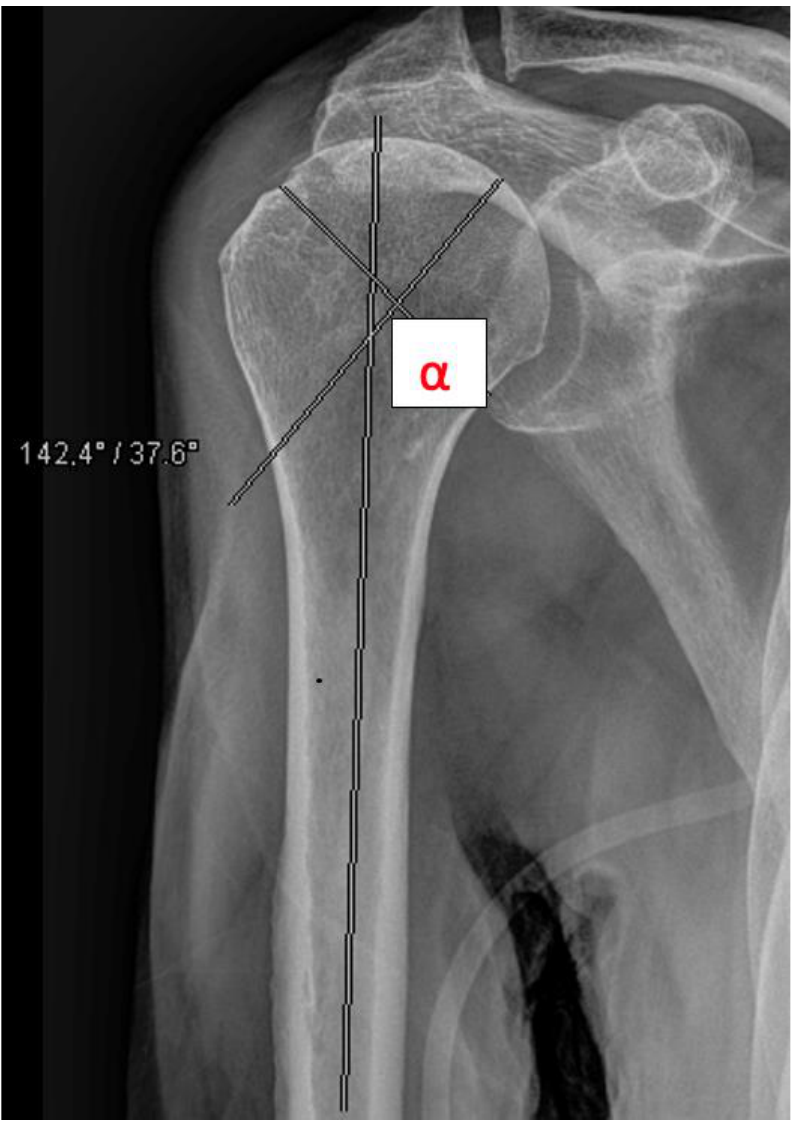
Figure 4. Measurement of the head shaft angle (HAS, e.g., 14.2°). Data analysis was performed with IBM SPSS Statistics (V21.0, SPSS Inc. Chicago, IL, USA) and Microsoft Excel (V16.3, Microsoft Cooperation, Redmond, WA, USA).